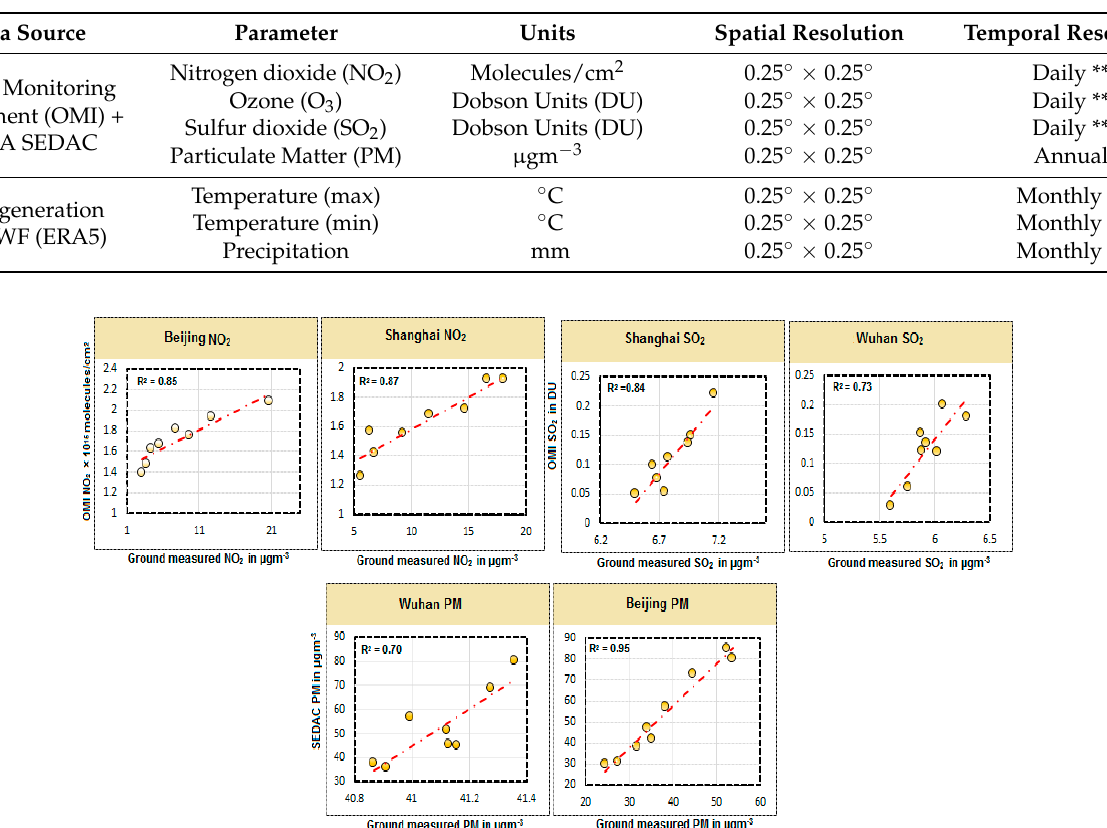
Figure 3. A comparison of the mean annual OMI measured column densities and NASA SEDAC PM with ground measured pollutants.